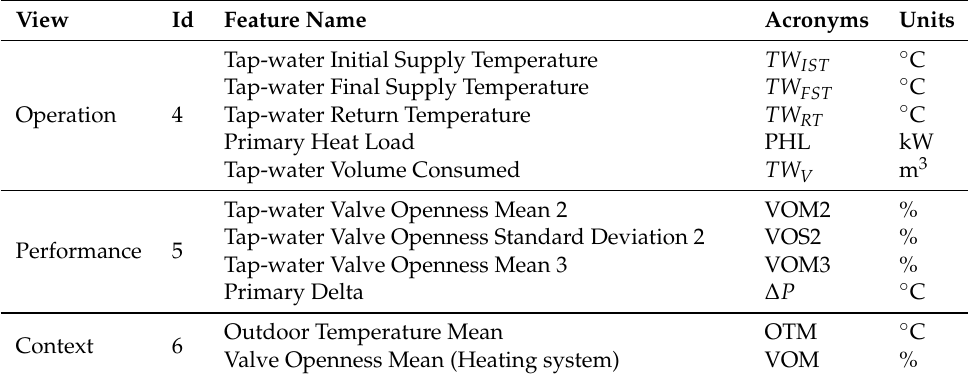
Table 12. Features used for monitoring the tap-water system.